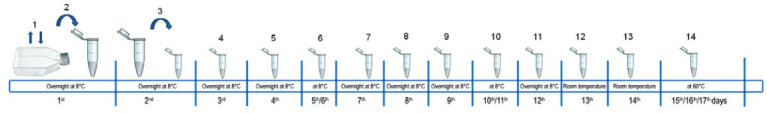
: protocol of low impact fixation of cells. (1-2) The culture medium was
changed by cacodilate buffered 1% glutaraldehyde and aliquots of 1.5 mL of the
cell suspension were kept overnight at 8ºC in 2 mL Eppendorf tubes; (3) a portion
of the fixative was gently removed and the cell-fixative-suspension was
transferred to smaller vials of 500 µL capacity; (4-5) the fixative was changed by
0.2 M cacodilate buffer added to 7% saccharose; (6) 0.2 M cacodilate buffer added
to 7% saccharose was changed by 1% aqueous osmium tetroxide; (7) washing with
distilled water and 0.2 M cacodilate buffer with 7% saccharose; (8) dehydration of
the sample with 30% acetone; (9) dehydration with 50% acetone; (10) dehydration
with 70% acetone; (11) dehydration with 90% acetone; (12) dehydration with 100%
acetone and resin infiltration; (13) resin infiltration; (14) resin
polymerization.